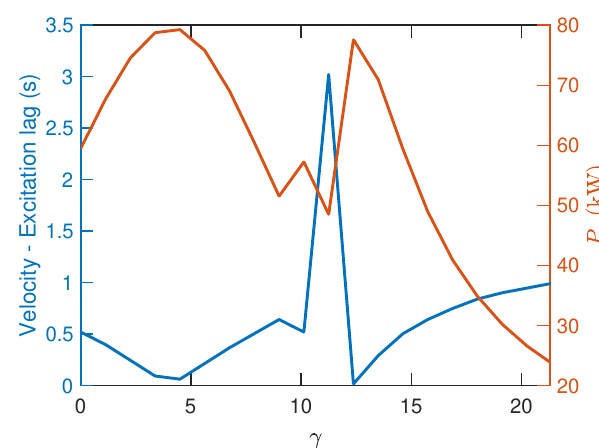
Fig. 9. The time domain relationship between the excitation force (right axis) and the velocity (left axis) for the non optimized PTO conditions and varying γ at frequency ω = 1 rad / s .